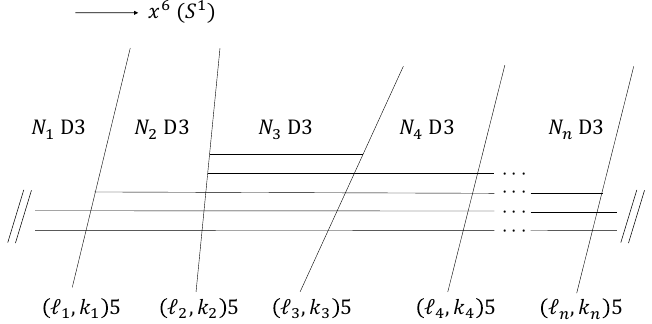
Figure 1 . A generic Hanany-Witten type brane configuration. The horizontal direction is the S 1 and therefore identified on the both ends. When ‘ ’s are 1, the worldvolume theory is a circular quiver gauge theory with the gauge group U( N